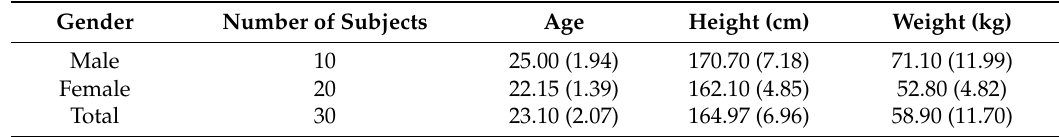
Table 1. General characteristics of